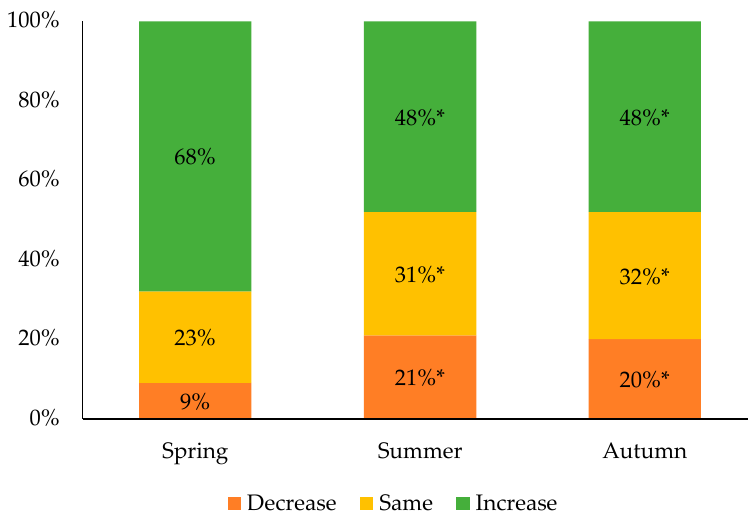
Figure 3. Evolution of recreational screen time compared to the winter 2020. * Significantly different from the spring; p < 0.001.